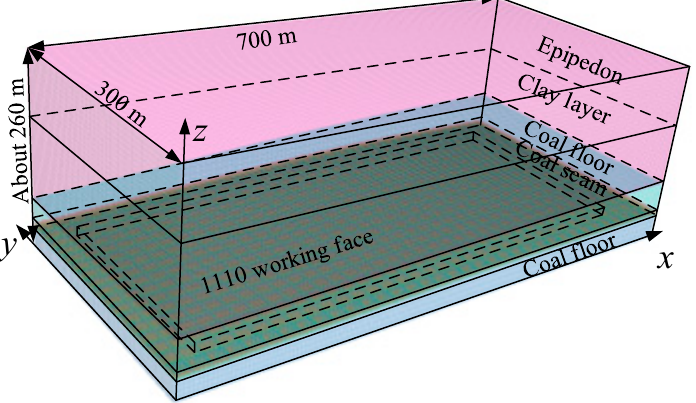
Figure 5. Numerical simulation model. The epipedon, clay layer, rock layers and coal seam are represented by different colors.